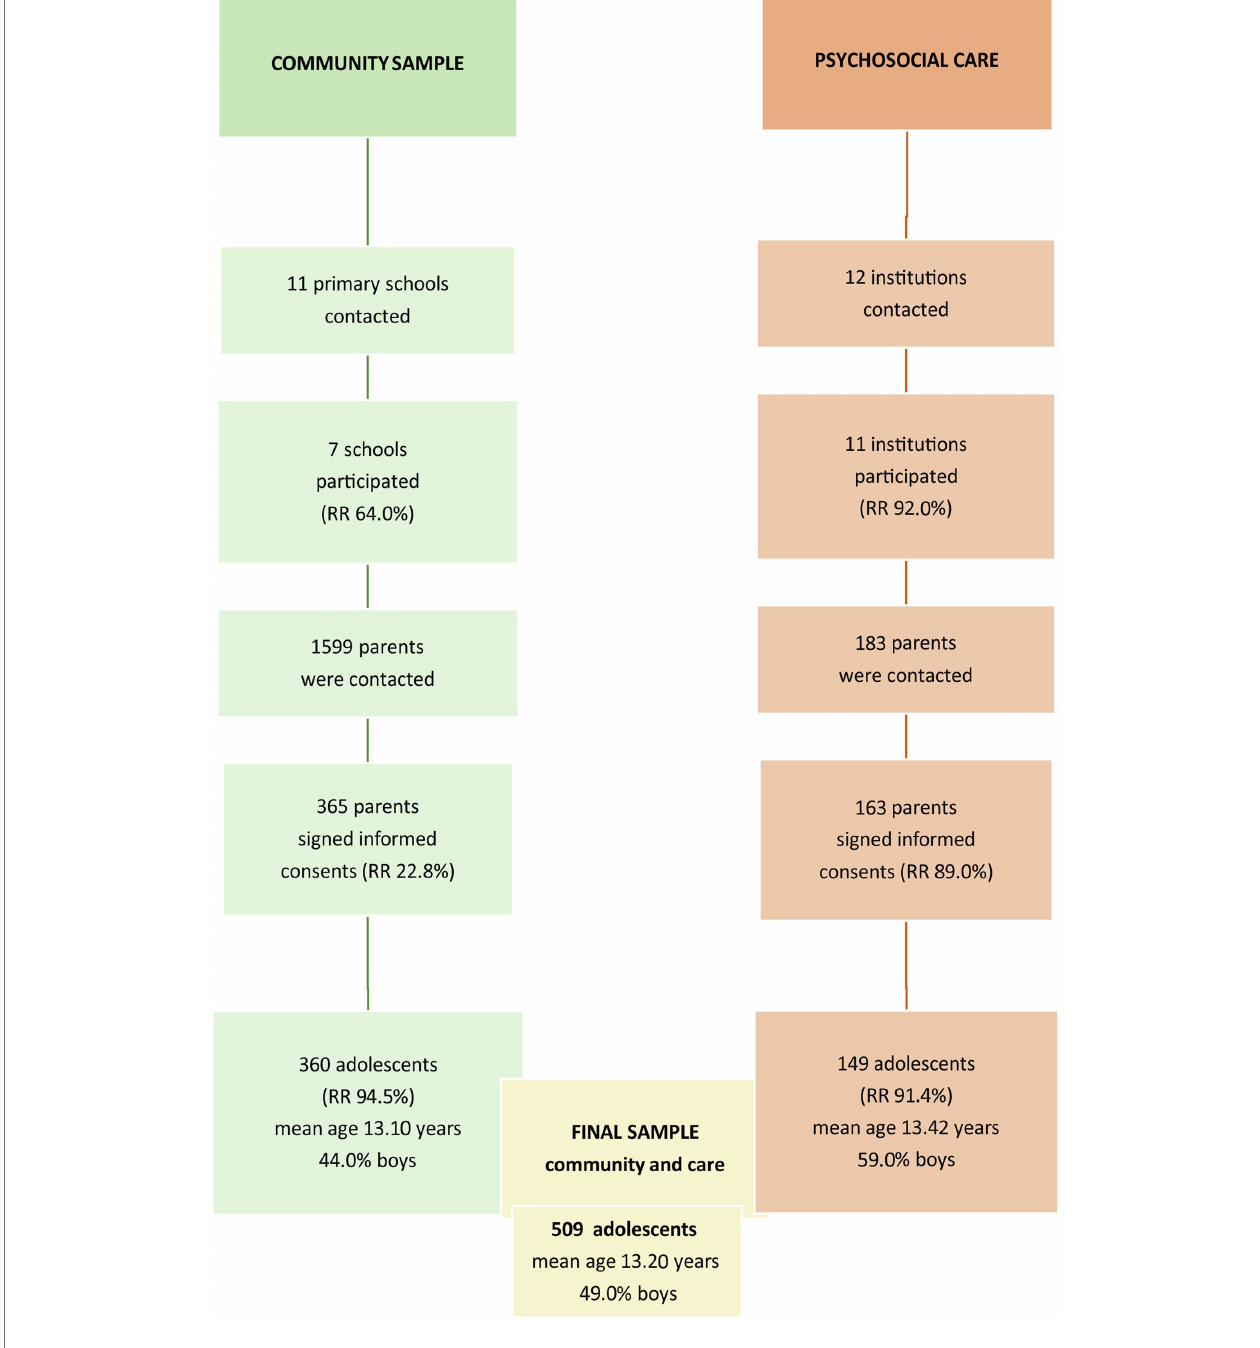
FIGURE 1 | Flowchart outlining the process of recruitment of participants from the Care4Youth study, Slovakia 2017, 10–16 years old, N =